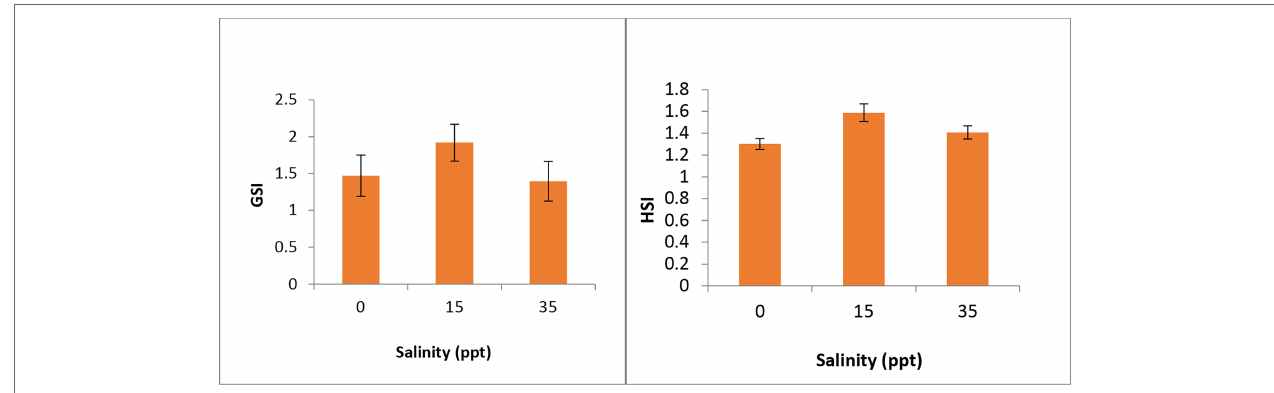
FIGURE 4 | Variation in Gonado-somatic index (GSI) and Hepato-somatic index (HSI) in P. maculatus reared in different salinities.